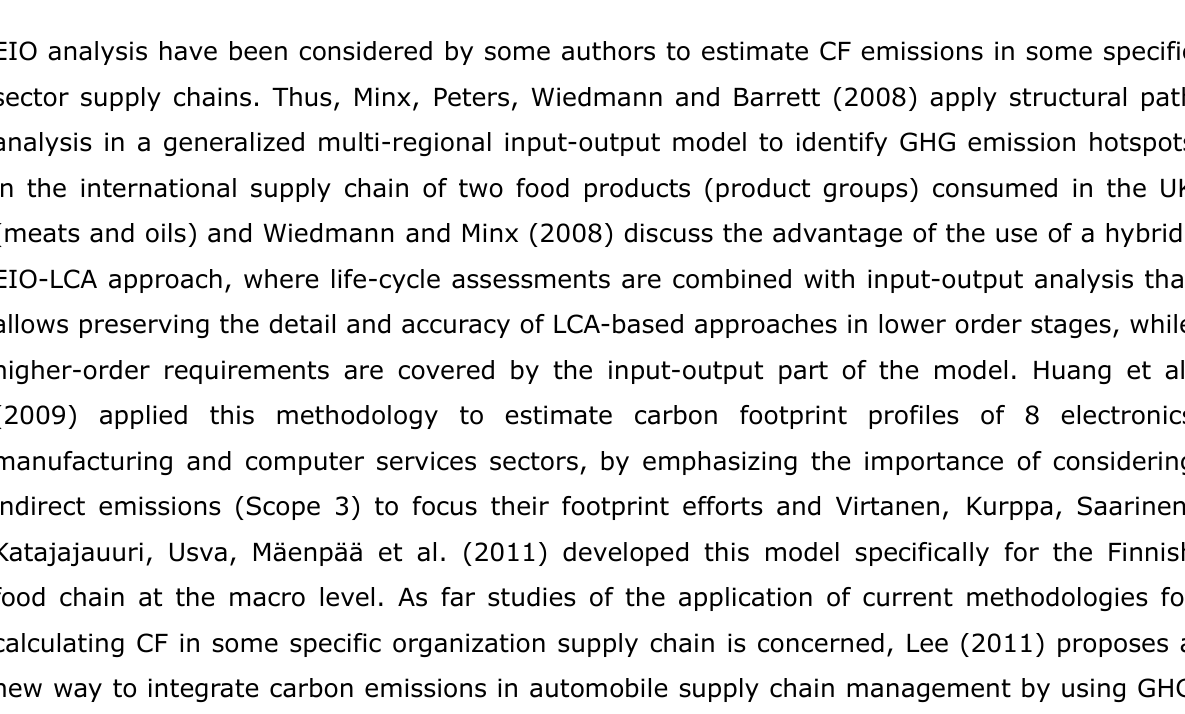
Table 2. Experiences in the application of CF methodologies in supply